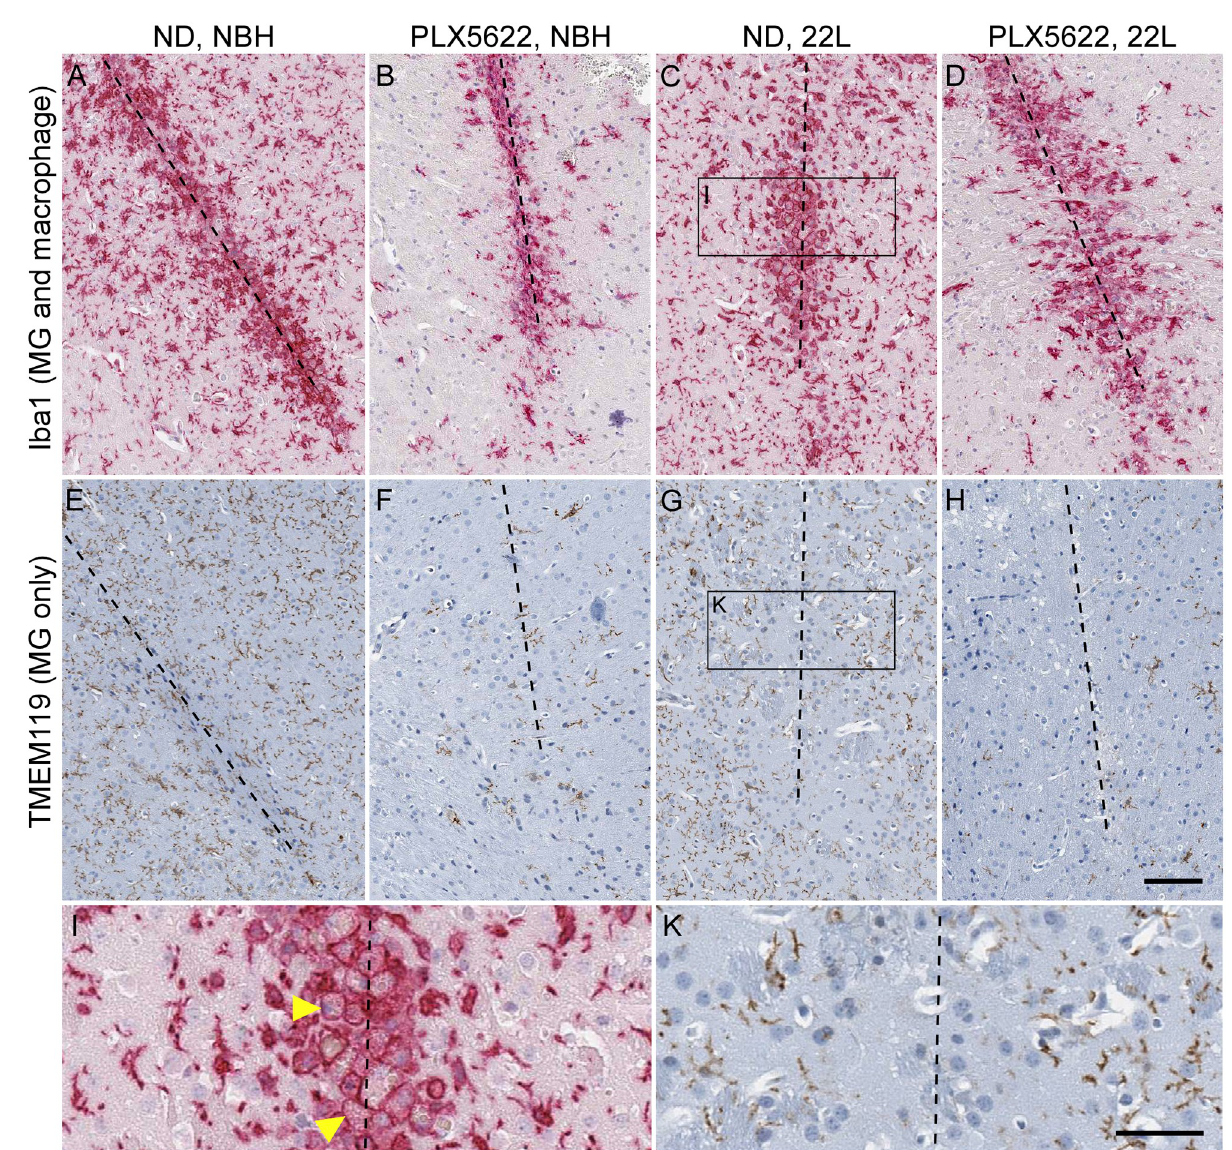
Fig 2. Immunohistopathology associated with the needle track three days post-inoculation. Mice were treated with PLX5622 from -7 (PLX5622) or untreated (ND), inoculated stereotactically with either normal brain homogenate (NBH) or 22L mouse scrapie in the striatum on day 0, and euthanized for analysis on day 3. The dashed line in each panel indicates the approximate location of the needle track. The antibodies used for immunohistochemistry are indicated on the far left. Anti-Iba1 is present on both microglia and macrophages while TMEM119 stains only microglia. By comparing the location of the Iba1 positive cells in the top row to the TMEM119 stained cells (microglia) in the second row, it appears nearly all the cells responding to the needle track trauma are macrophages. Also note the reduced number of TMEM119 positive cells in the PLX5622 treated mice (compare panels E&G to F&H). The rectangular insets shown in panels C and G are enlarged in panels I and K respectively. The yellow arrowheads in panel I point to examples of macrophages full of red blood cells. The scale bar in panel H is 100 μ m and applies to panels A-H. The scale bar in panel K is 50 μ m and applies to panels I and